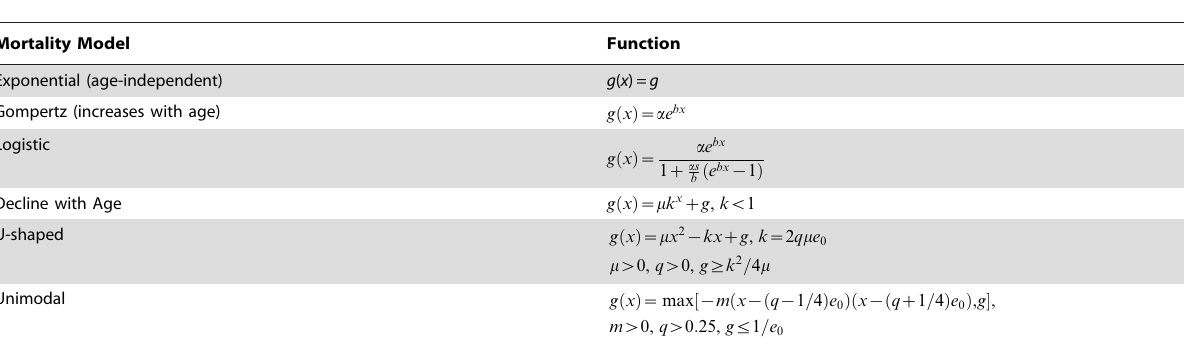
Table 3. Mortality models used in this